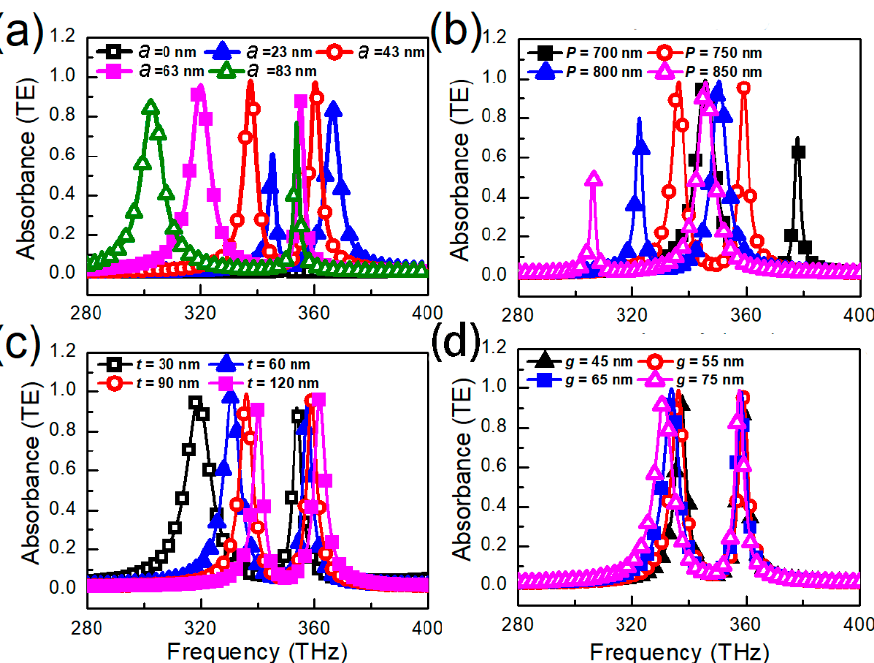
Figure 5. Absorbance spectra depending on the radius a ( a ), period p ( b ) thickness t ( c ), and elliptical silt gap g ( d ) of perfect absorber for TE-polarized wave.